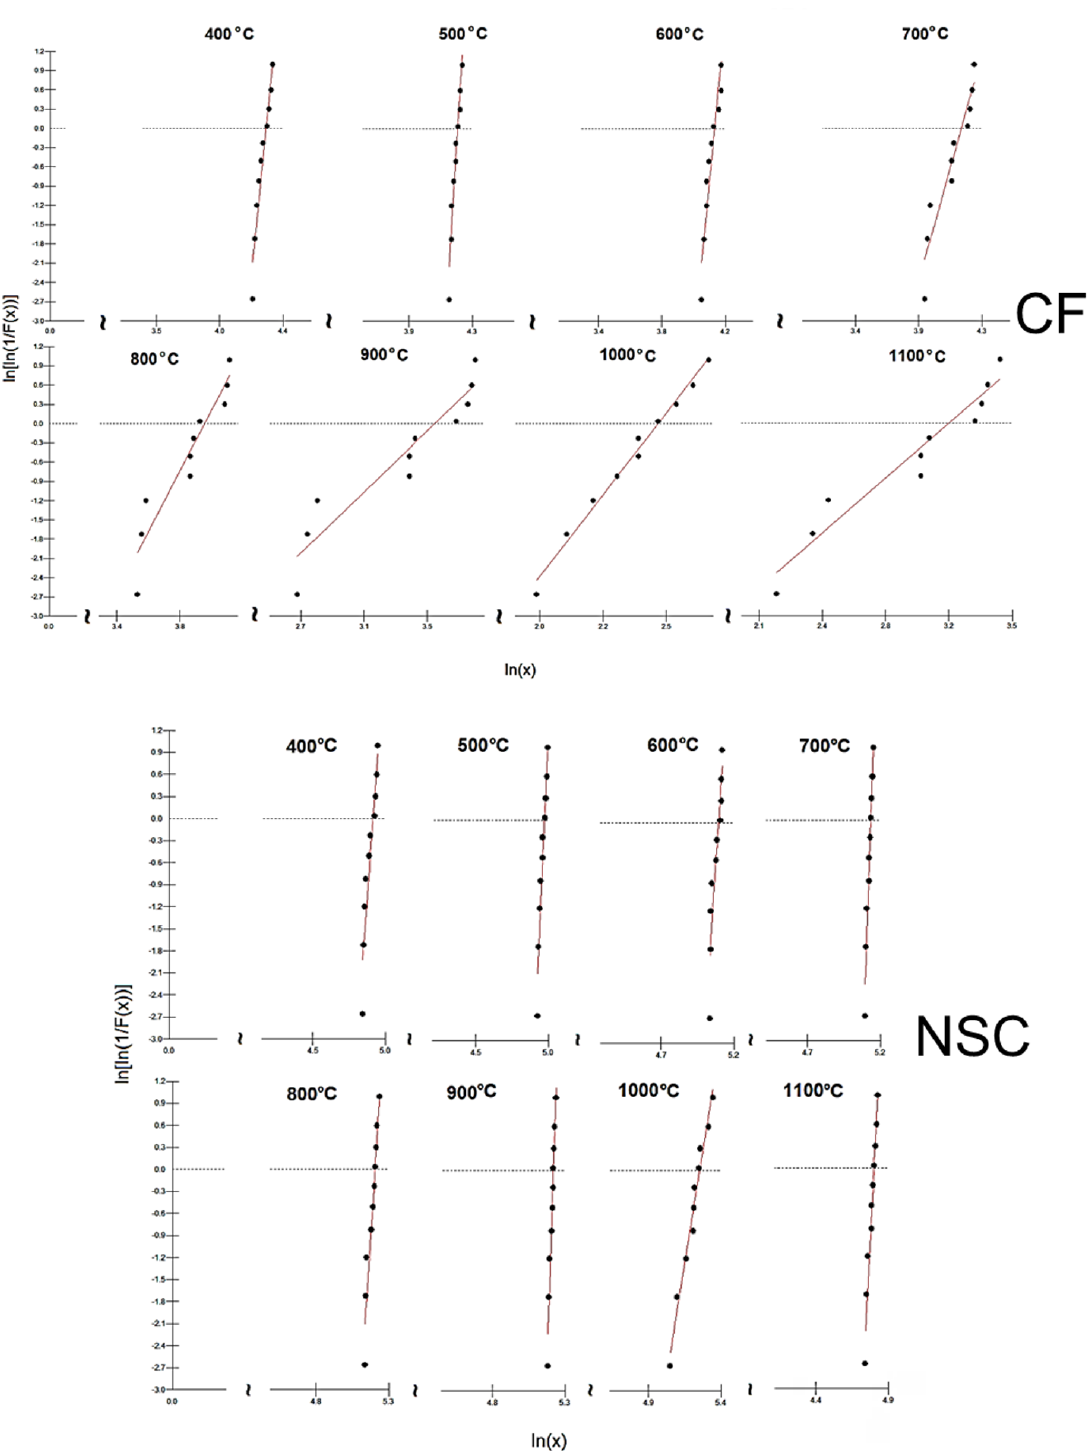
Figure 8. Weibull distribution curves for the water absorption results of clay fraction (CF) and natural silty clay (NSC) fired at different